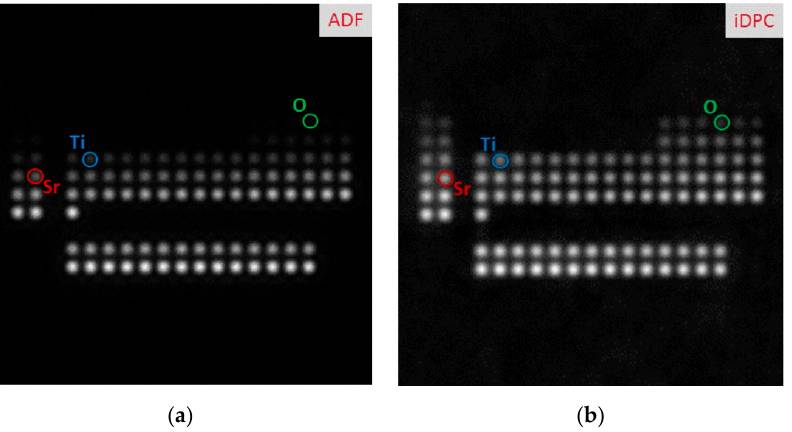
Figure 5. The comparison of single-atom contrast in the range Z = 1–103 obtained by simulations: HAADF-STEM image ( a ) and iDPC-STEM image ( b ) Reprinted/adapted with permission from Ref. [24]. Copyright 2016, Cambridge University Press.